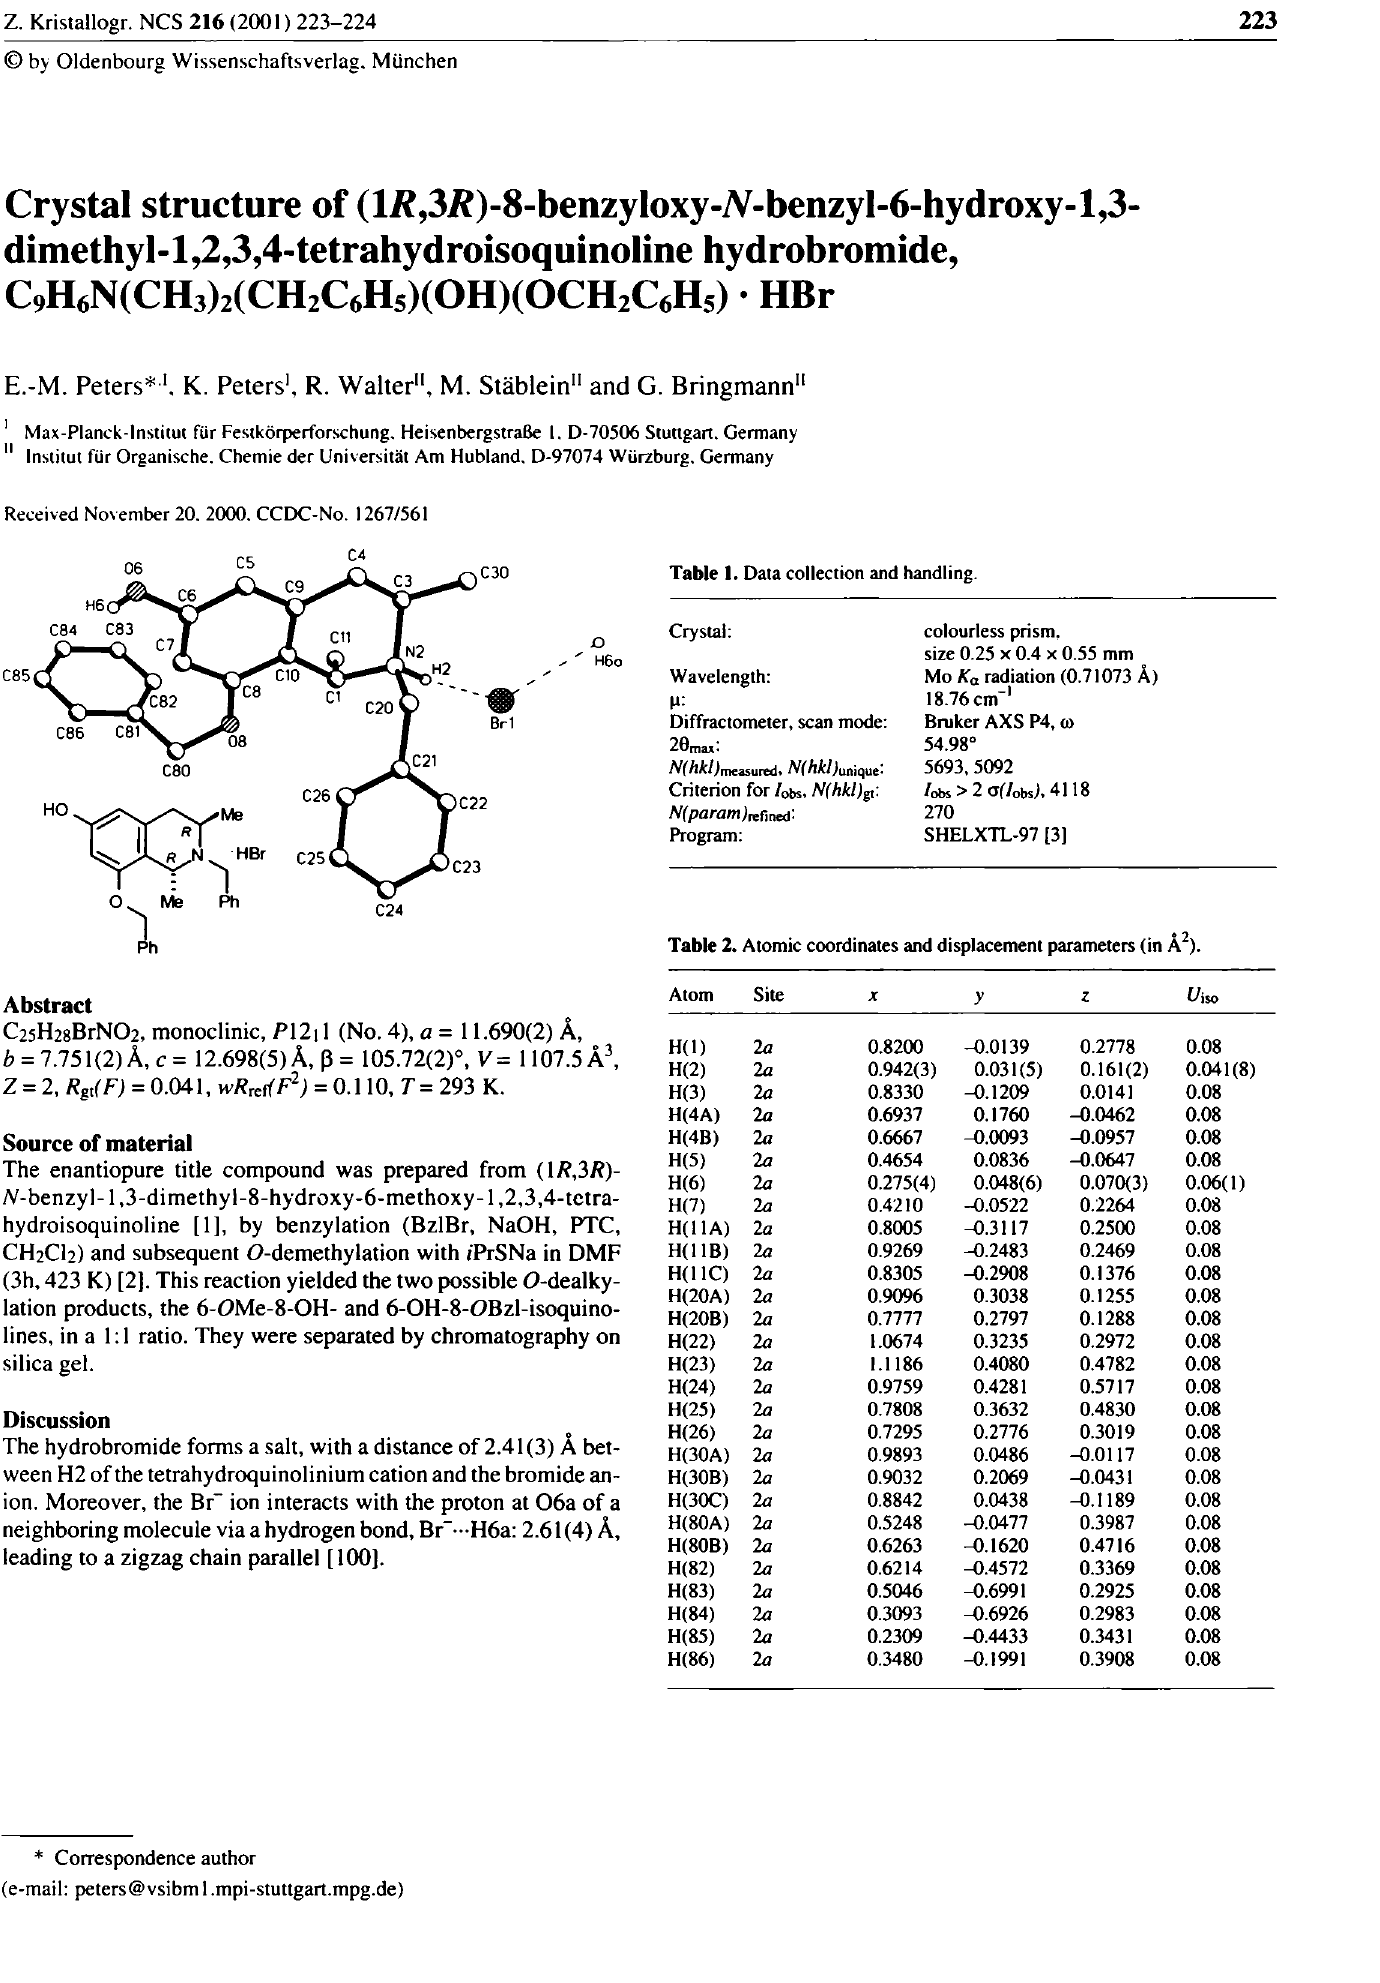
Table 2. Atomic coordinates and displacement parameters (in A